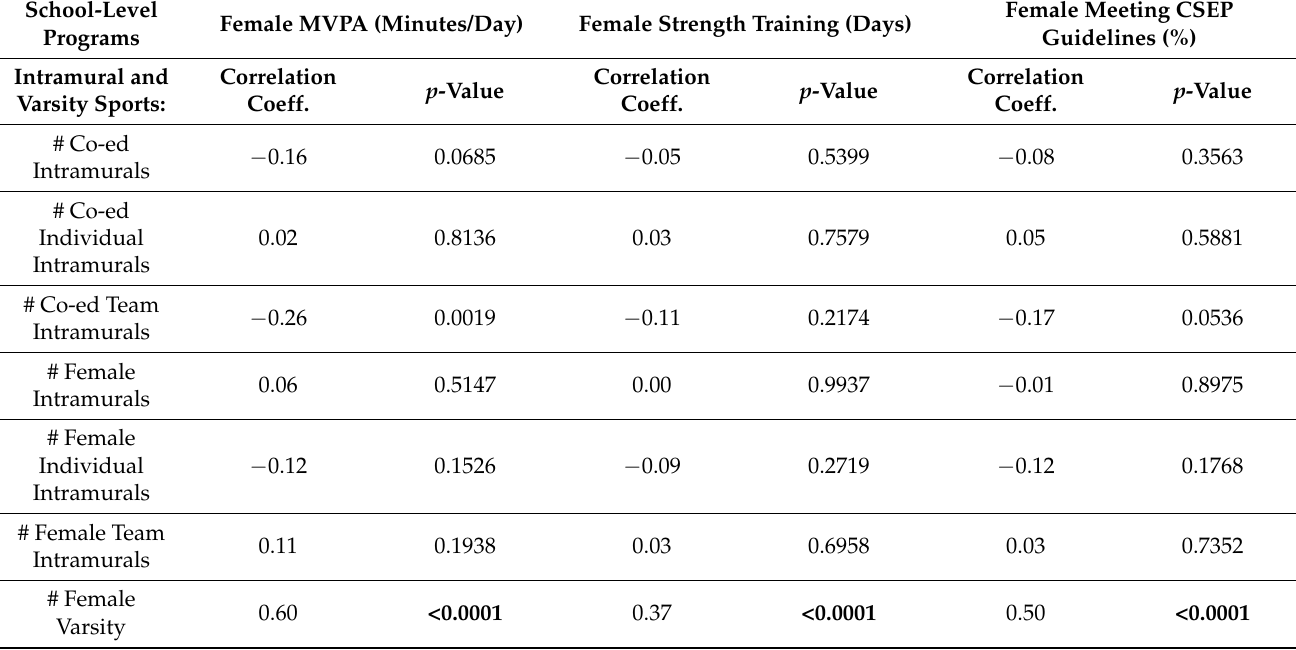
Table 2. Associations between School-Level Programs and Physical Activity Outcomes among Female Students from Year 7 (2018–2019) of the COMPASS